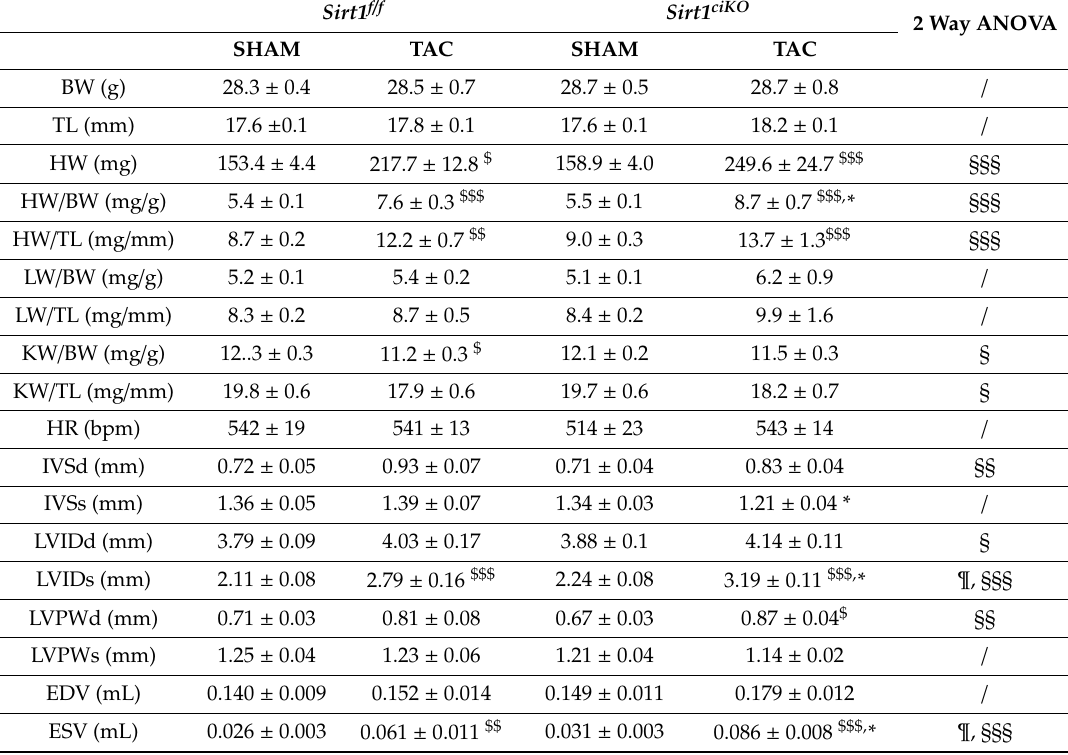
Table 2. Anatomical and echocardiographic parameters 8 weeks after induction of pressure overload in Sirt1 f / f and Sirt1 ciKO mice. BW, Body weight. TL, Tibia length. HW, Heart weight. HW / BW, Heart weight-to-body weight ratio. HW / TL, Heart weight-to-tibia length ratio. LW / BW, Lung weight-to-body weight ratio. LW / TL, Lung weight-to-tibia length ratio. KW / BW, Kidney weight-to-body weight ratio. KW / TL, Kidney weight-to-tibia length ratio. HR, Heart rate. IVSd, Interventricular septal thickness at end-diastole. IVSs, Interventricular septal thickness at end-systole. LVIDd, Left ventricular internal dimension at end-diastole. LVIDs, Left ventricular internal dimension at end-systole. LVWPd, Left ventricular posterior wall thickness at end-diastole. LVWPs, Left ventricular posterior wall thickness at end-systole. EDV, Left ventricular telediastolic volume. ESV, Left ventricular telesystolic volume. LVEF, Left ventricular ejection fraction. LVFS, Left ventricular fractional shortening. SV, Stroke volume. LV, left ventricular mass. CO, Cardiac output. ANOVA: ¶ p ≤ 0.05, ¶¶ p ≤ 0.01, ¶¶¶ p ≤ 0.001 for the genotype e ff ect; § p ≤ 0.05, §§ p ≤ 0.01, §§§ p ≤ 0.001 for the TAC e ff ect; i p ≤ 0.05, ii p ≤ 0.01 for the interaction e ff ect. Post hoc Newman–Keuls test: * p ≤ 0.05, ** p ≤ 0.01, *** p ≤ 0.001 Sirt1 f / f vs. Sirt1 ciKO (same surgery); $ p ≤ 0.05, $$ p ≤ 0.01, $$$ p ≤ 0.001 Sham vs. TAC (same